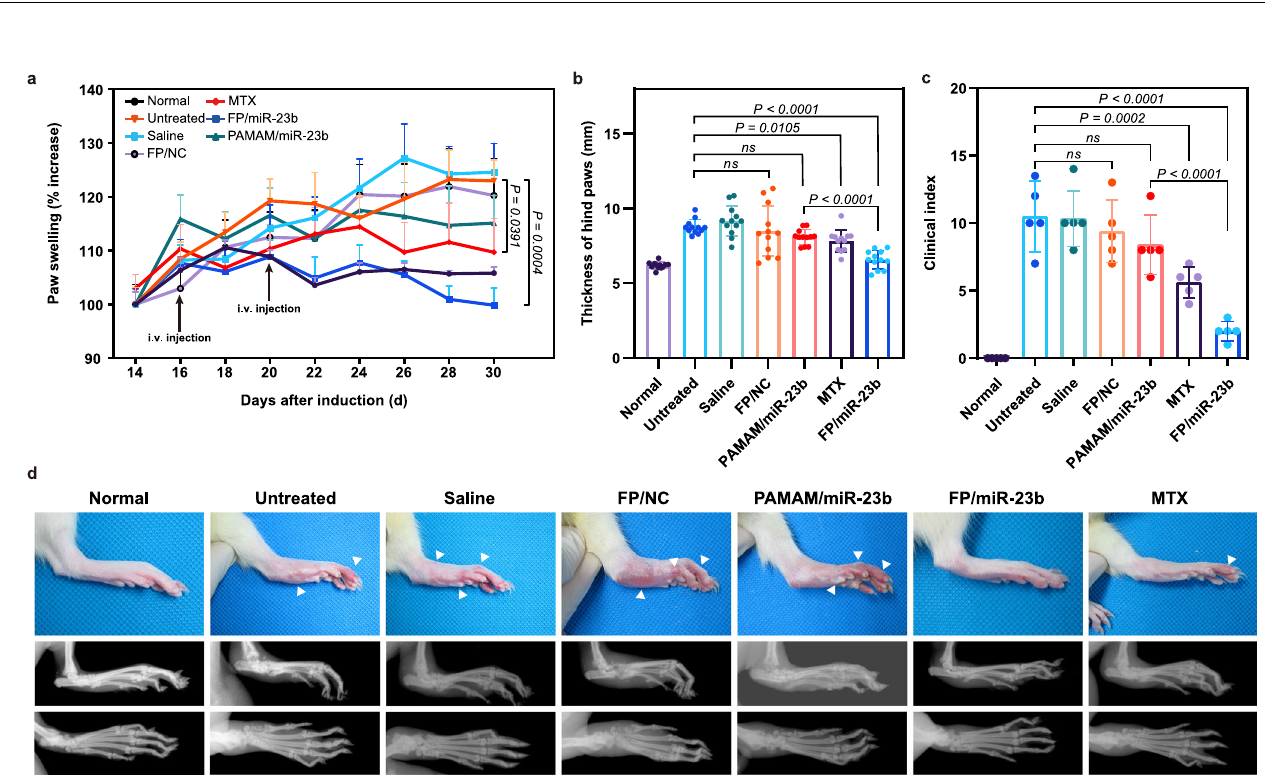
Fig. 5 | Therapeutic ef fi ciency of FP/miR-23b nanoparticles in AIA rat model in terms of changes in in fl amed paws. a The increase ratio of hind paw swelling during the period of 30 days post-adjuvant induction. Data are presented as mean value±SD ( n =6 independent animals). b The thickness of hind paws assessed at day 30 post-adjuvant induction. Data are presented as mean value±SD ( n =12 independent samples). c The clinicalindexes offoreand hind paws assessed at the day 30post-adjuvantinduction.The clinicalindexes wereperformed on 0 – 4scale, where 0=no signs of swelling or erythema; 1=slight erythema and/or